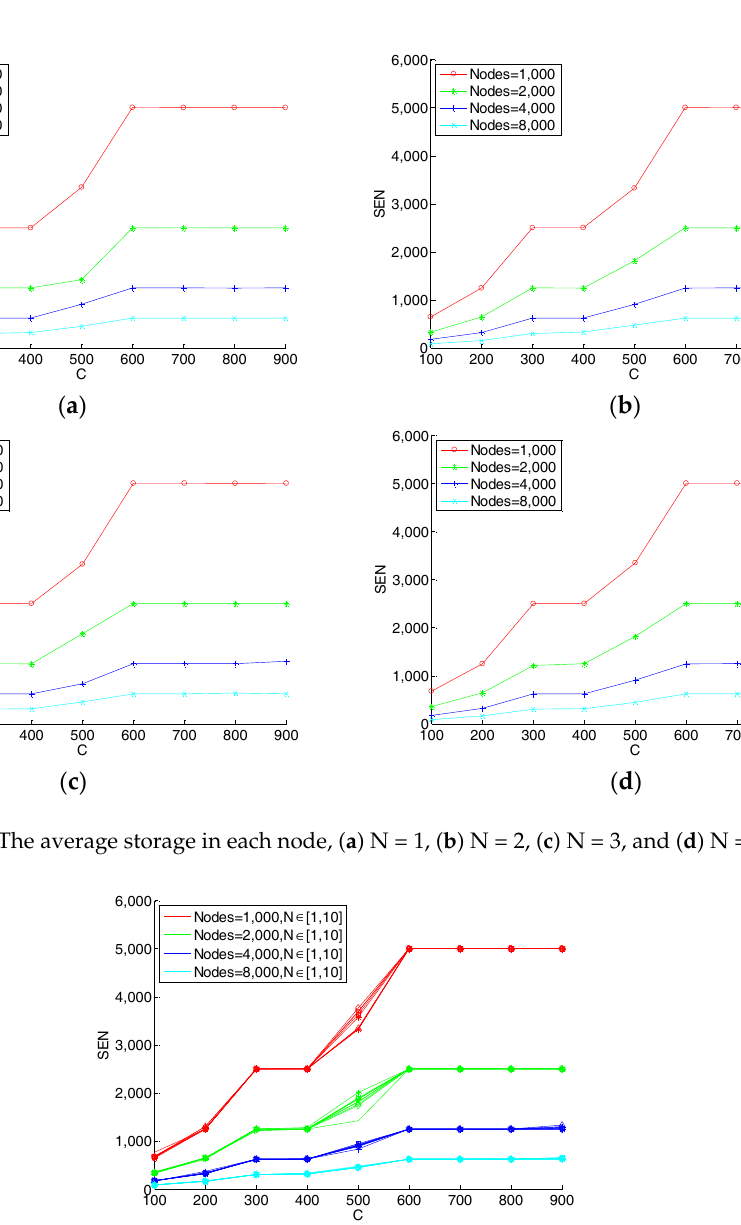
Figure 8. The average storage in each node.